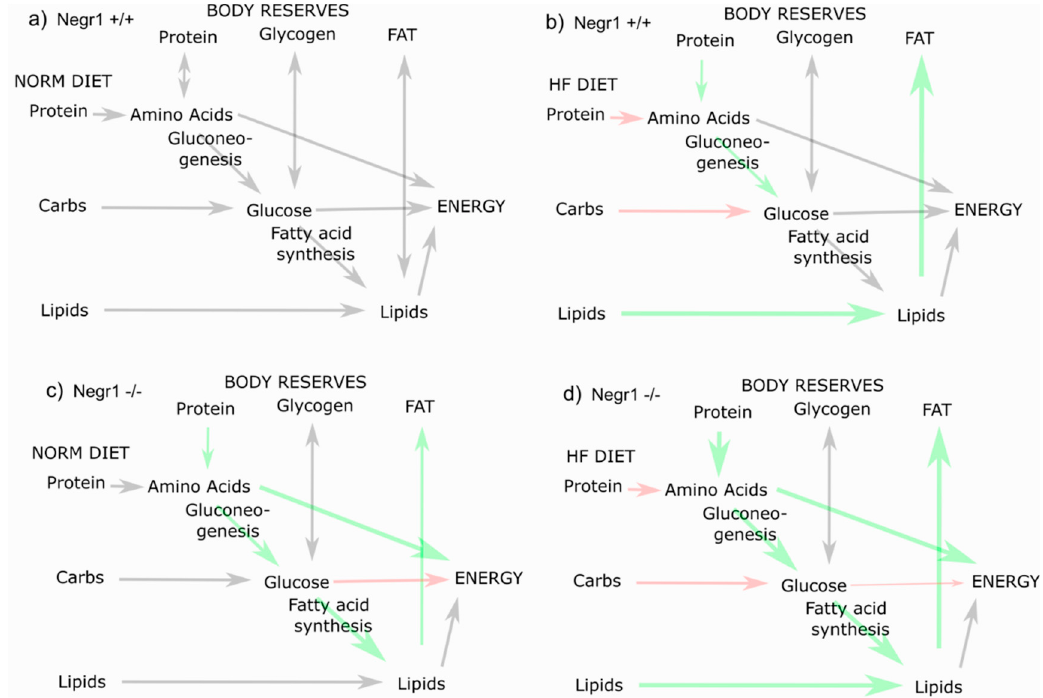
Figure 8. A hypothetical and simplified scheme of the metabolic differences in wild-type ( Negr1 +/+ ) ( a , b ) and Negr1 − / − ( c , d ) mice on a normal diet ( a , c ) and high-fat diet ( b , d ). Increased size and green color indicate increased metabolic flux, reduced arrow size and red color indicate inhibited process.